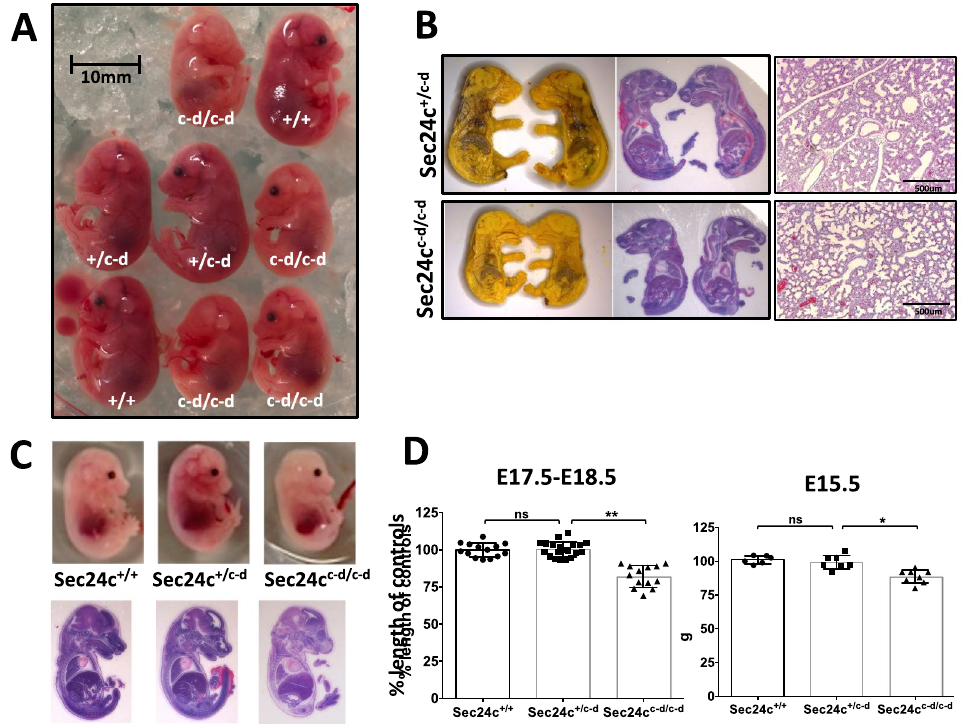
Figure 4. Phenotypic assessment of Sec24c + /c-d intercross embryos. ( A ) Side views of embryos from Sec24c + /c-d intercross at E17.5 (N = 8). Eye pigment variation is normal in inbred mice and did not track with the mouse genotypes. ( B ) Bouin’s solution fixed E18.5 embryos sectioned at the midline (left) and stained with H&E (center). H&E of 4% PFA fixed lungs from E18.5 embryos are shown at right. A total of 13 embryos were analyzed. ( C ) Whole mount and H&E images of E15.5 embryos from Sec24c + /c-d intercross (N = 15 analyzed). ( D ) Crown to rump length measurements at E17.5–18.5 and E15.5, normalized to average length of controls ( Sec24c + / + and Sec24c + /c-d ) within the same litter. ** indicates p < 0.0001; * indicates p < 0.002; ns indicates p > 0.05. Error bars represent the standard deviation.